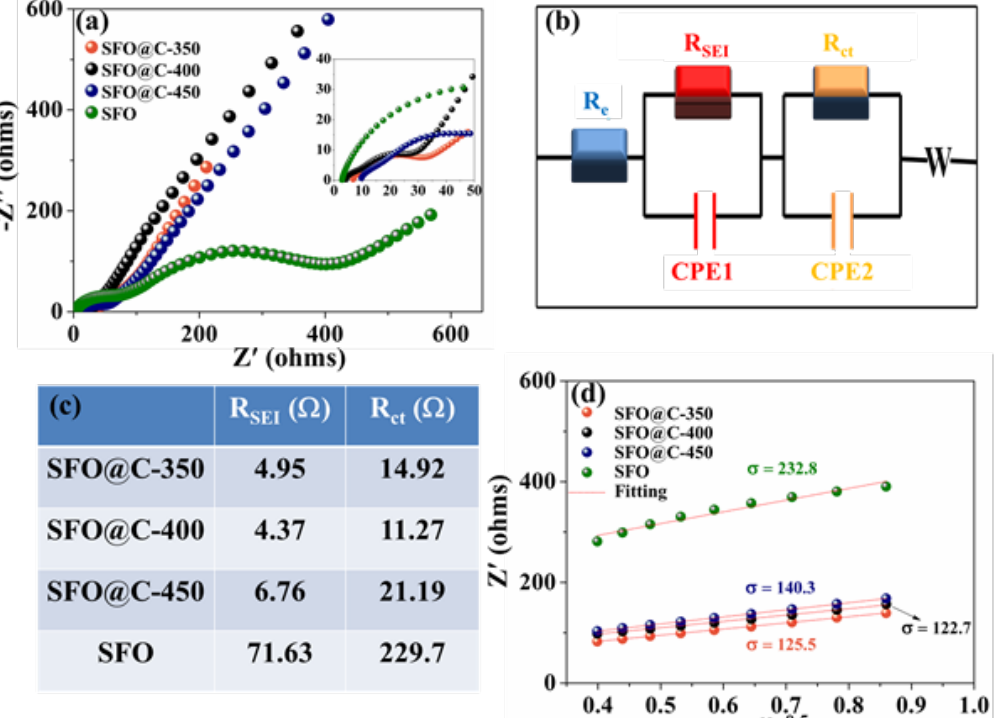
Figure 6. ( a ) Electrochemical impedance spectra of the SFO@C electrodes and SFO electrode after the first cycle in a fully charged state; ( b ) the equivalent circuit and ( c ) the corresponding fitted results of the resistance of SEI layer (R SEI ) and the charge transfer impedance (R ct ) of SFO@C electrodes and SFO electrode; ( d ) Warburg impedance spectra.